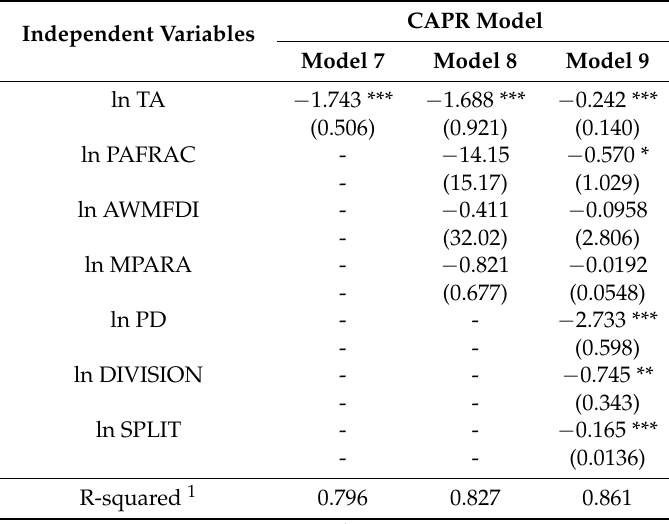
Table 9. Estimation results for CAPR